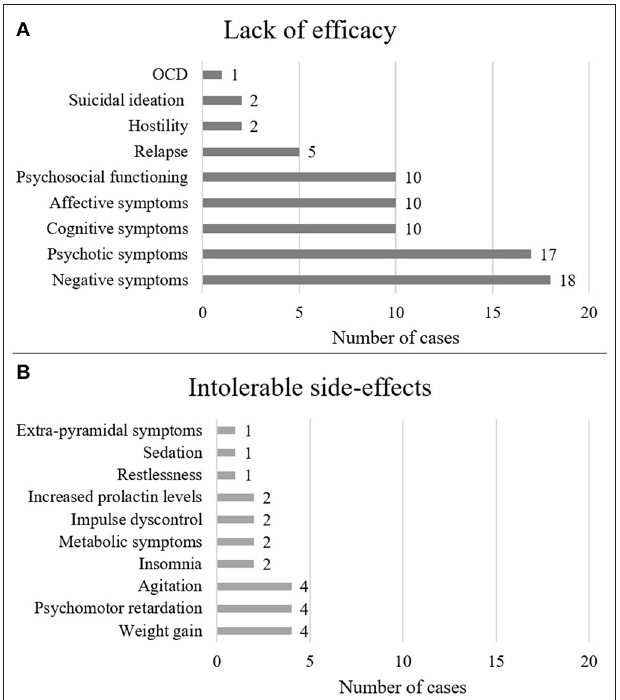
TABLE 1 | Summary of results.